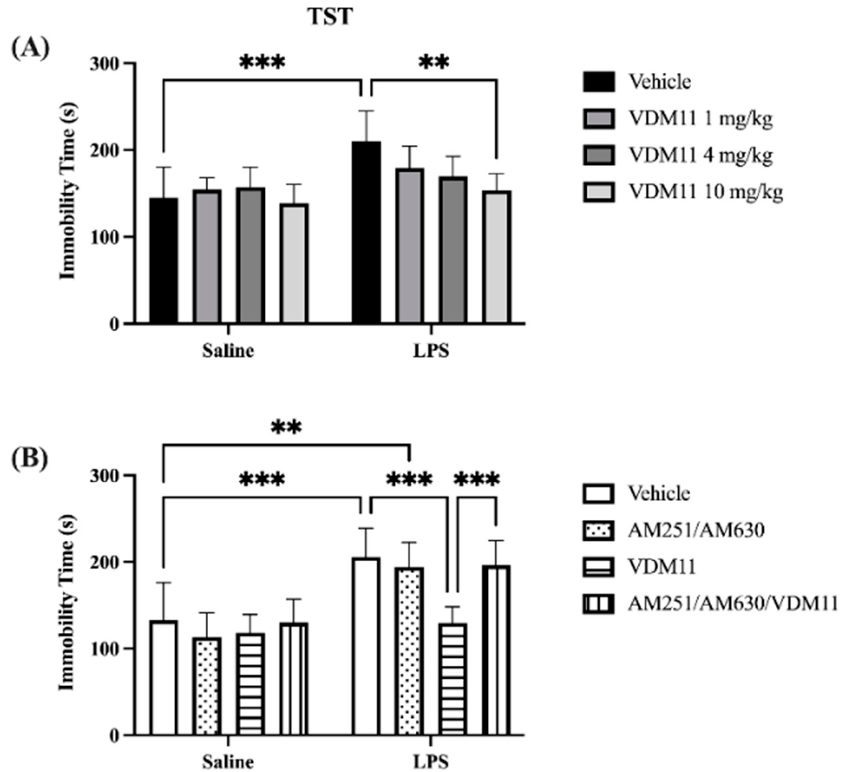
Figure 9. ( A ) A significant reduction in immobility time (s) during the tail suspension test (TST)